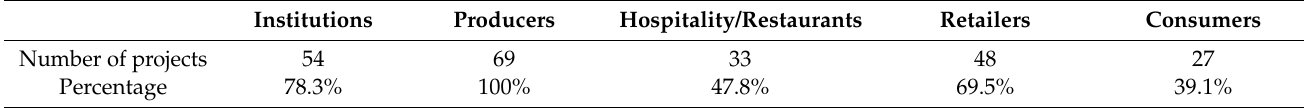
Figure 6. AFNs used in the projects we analyzed (%). Table 1. Direct participation of the different actors in the selected